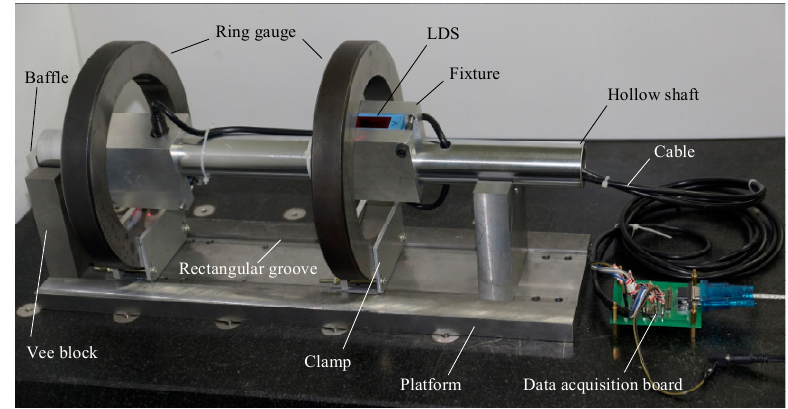
Figure 10. The diameter measurement system for coaxial holes.